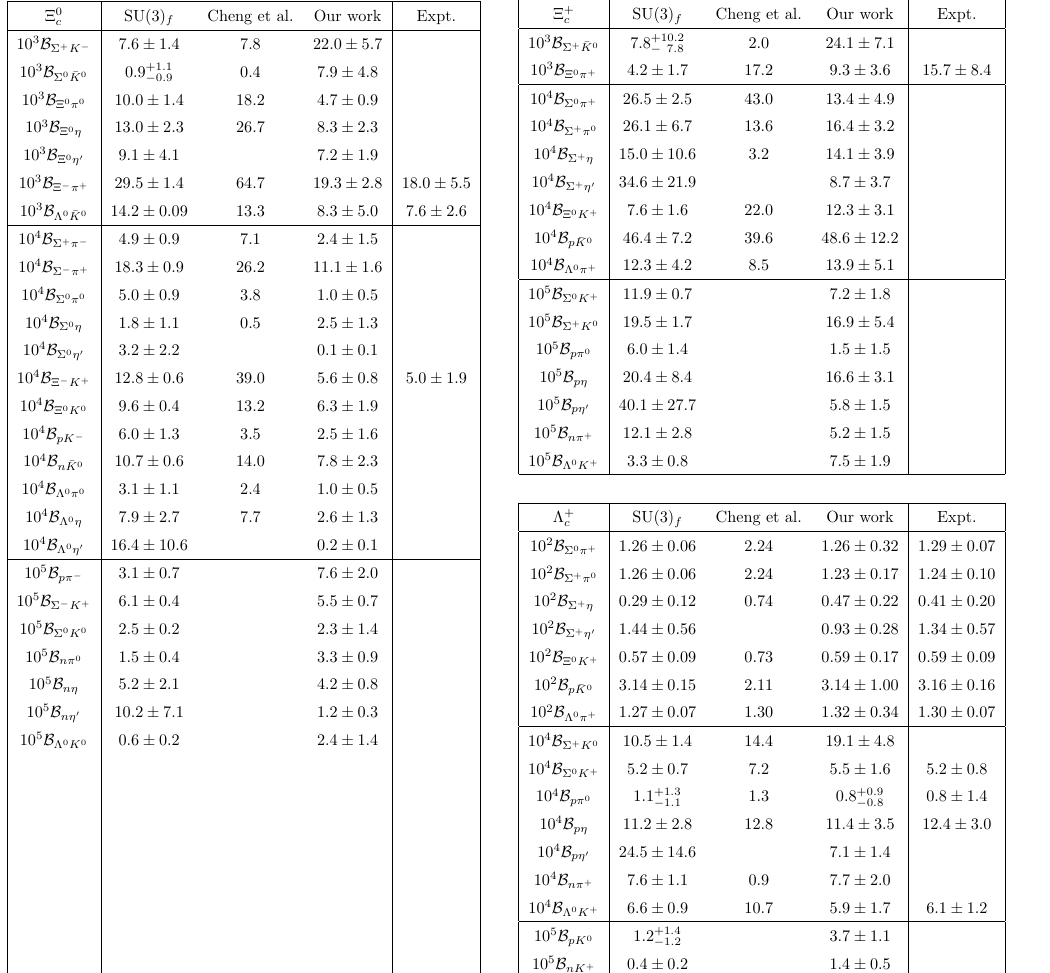
B M decays with ( B c B M ), in comparison ! B B M (cid:17) B ! ((cid:4) 0 (cid:4) (cid:0) K + ; (cid:3) 0 (cid:22) K 0 ) are extracted with c ! B